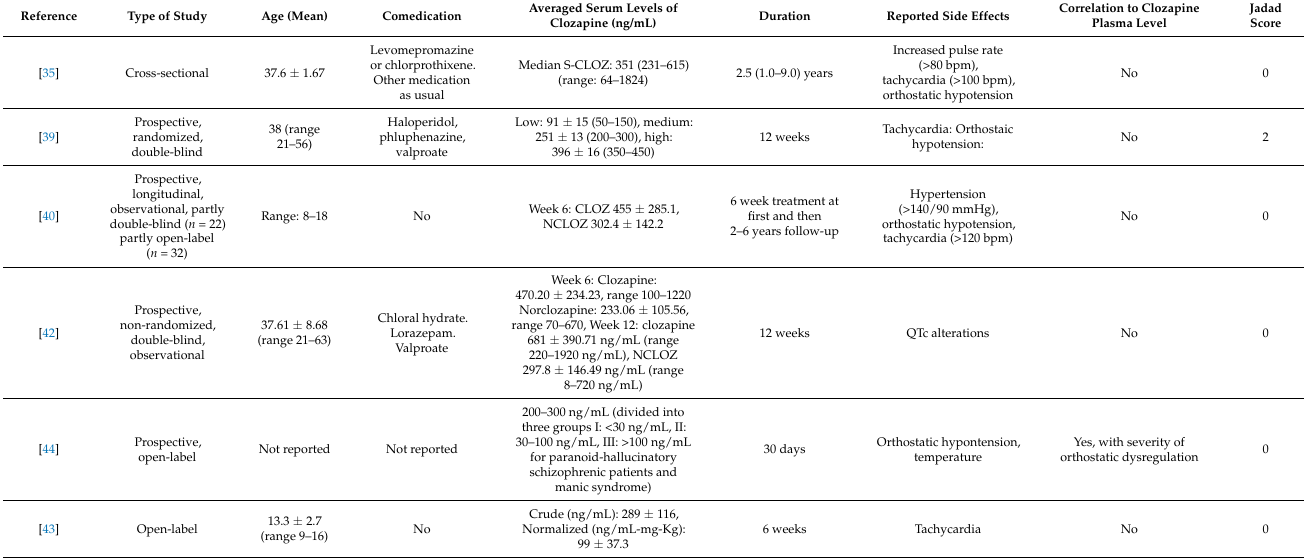
Table 4. Cardiovascular adverse effects in relation to CLOZAPINE blood